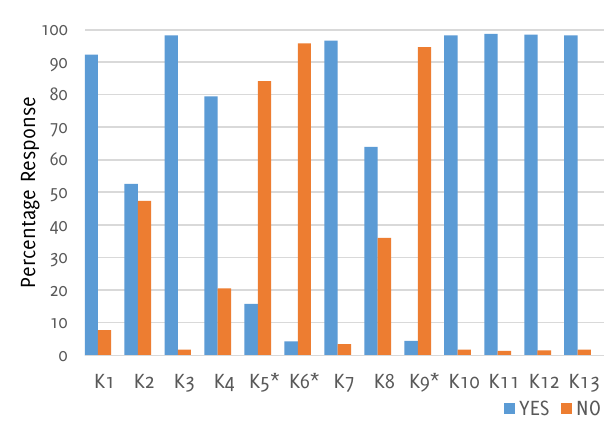
Figure 2 . Percentages of Responses to Each of the Knowledge Questions.